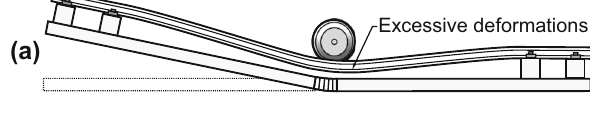
Fig. 2 Bridge movements and corresponding joint rotations,